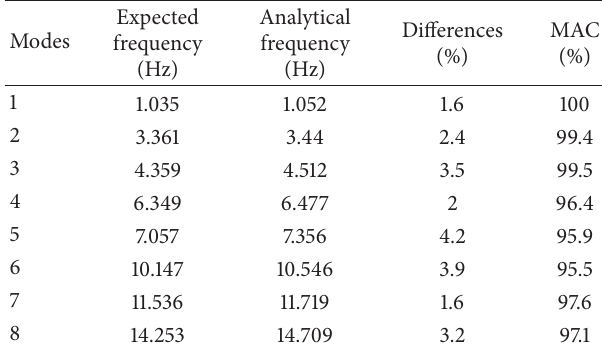
Table 2: Eigen errors on Group